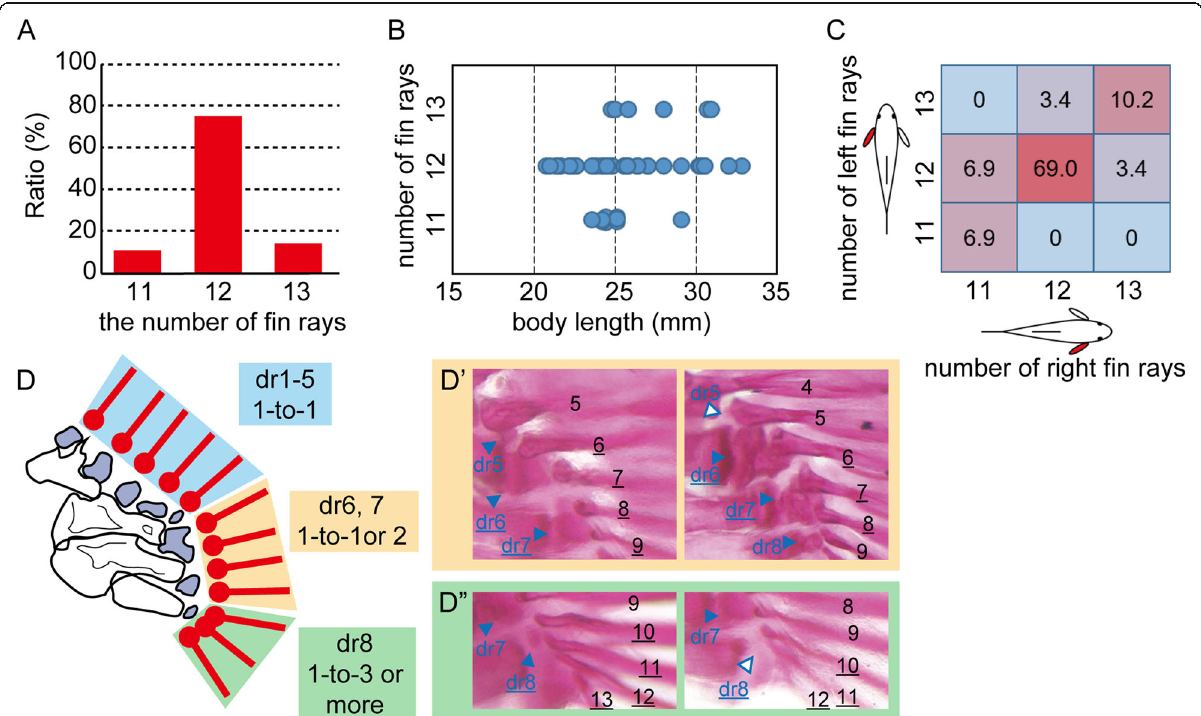
Fig. 2 Observation of skeletal anatomy of the pectoral fin in the RW strain . a Distribution of the variation in fin ray number. b Relationship between the number of rays and body length. Blue circles indicate individuals. c Ratio of the combination of the numbers of fin rays in the left and right pectoral fins. d . Schematic drawing of the connection between the fin rays (red bar with circle) and distal radials (dark blue). Light blue, orange, and green boxes indicate the relationship in the one-to-one, one-to-one or two, and one-to-three or more modes, respectively. d ’ . Connection between fin rays and the sixth and seventh radials. The seventh radial showed connection in a one-to-two mode; the sixth radial showed the connection in a one-to-two (left panel) or a one-to-one (right panel) mode. d ” . Connection between the fin rays and the eighth radial. The number of fin rays connected to the eighth radial varied (four rays in the left panel and three rays in the right panel). Blue-colored arrowheads with dr5 – 8 indicate the 5th to 8th distal radials, respectively. Blue-outlined arrowheads with dr5 in the right panel of d ’ and dr8 in the right panel of d ” indicate the absence of the 5th and 8th distal radials, respectively. Black-colored numbers indicate fin ray numbers. Underlined characters in d ’ indicate the 6th and 7th distal radials and the fin rays connected to them. Underlined characters in d ” indicate the 8th distal radial and the fin rays connected to